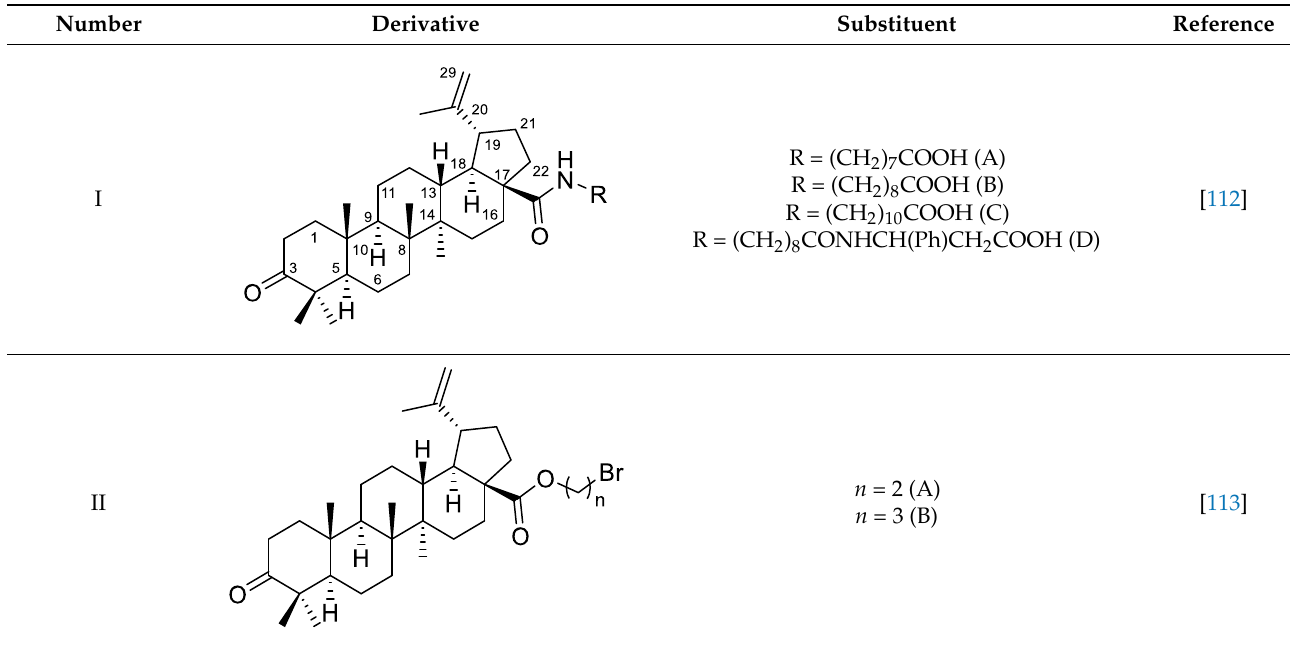
Table 1. Betulonic acid